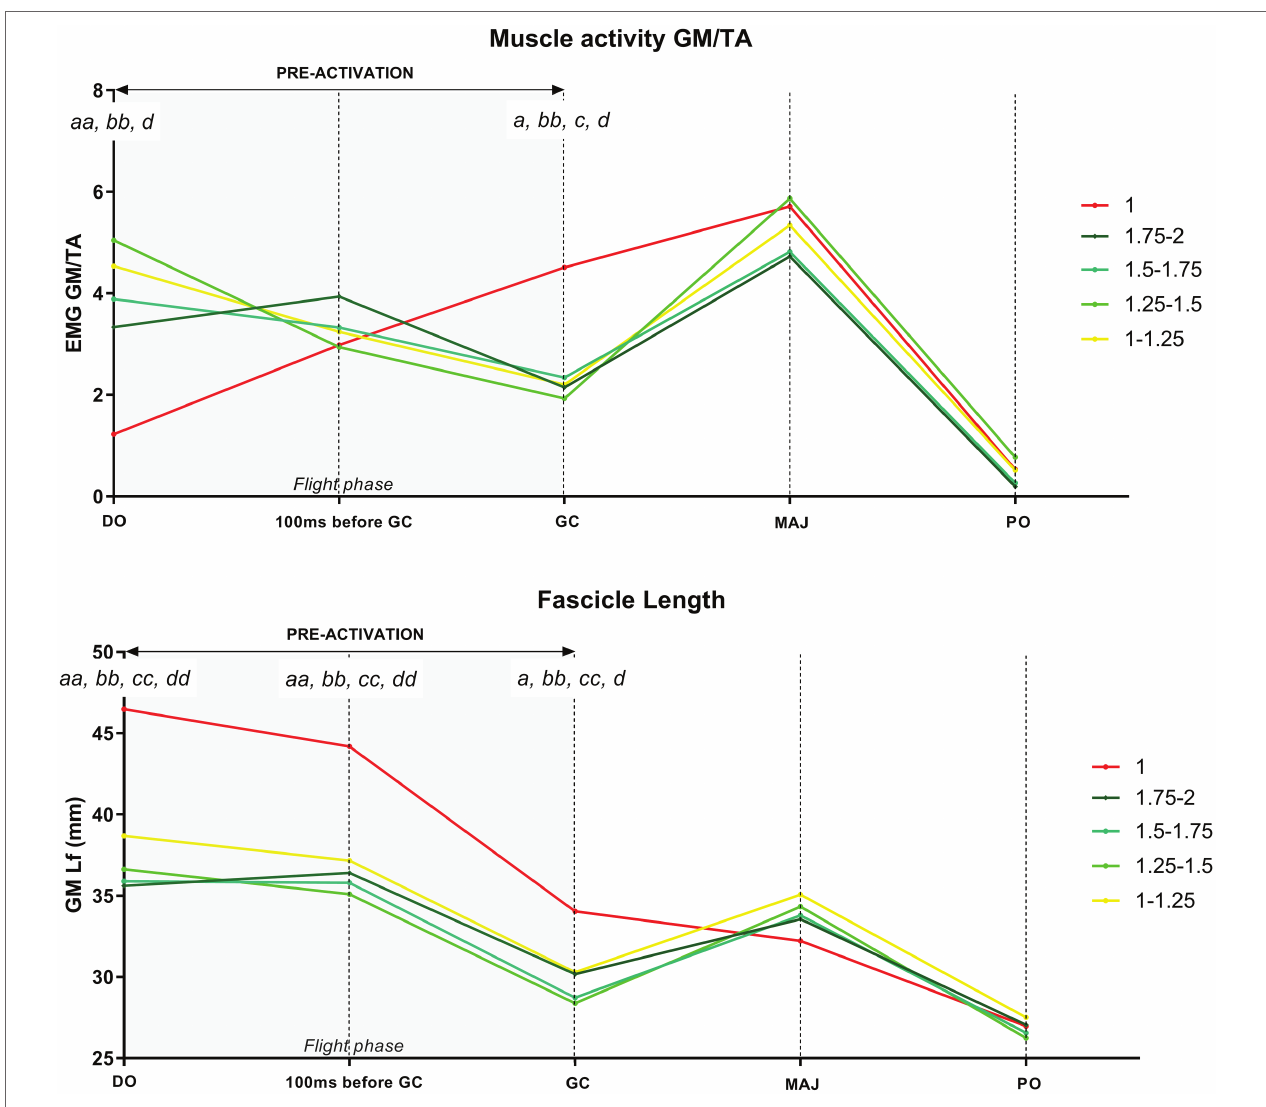
FIGURE 9 | Time course of the gastrocnemius medialis/tibialis anterior (GM/TA) EMG and fascicle length (Lf) during the five drop jump time points – drop-off (DO), 100 ms before ground contact (GC), GC, MAJ, push-off (PO) – in hyper-gravity (1–1.25 g, 1.25–1.5 g, 1.5–1.75 g, and 1.75–2 g) and 1 g. Results shown as grand means of maximum three jumps per gravity level per subject. GM Lf at 110 ° (bipedal standing on the platform) was 57.4 mm. GM at DO ranged from 46.5 mm (1 g, 130.4 ° ankle angle) to a minimum of 35.6 mm (139.9 ° ankle angle). a p < 0.05 1 g vs. 1–1.25 g; aa p < 0.01 1 g vs. 1–1.25 g; bb p < 0.01 1 g vs. 1.25–1.5 g; c p < 0.05 1 g vs. 1.5–1.75 g; cc p < 0.01 1 g vs. 1.5–1.75 g; d p < 0.05 1 g vs. 1.75–2 g; dd p < 0.01 1 g vs. 1.75–2